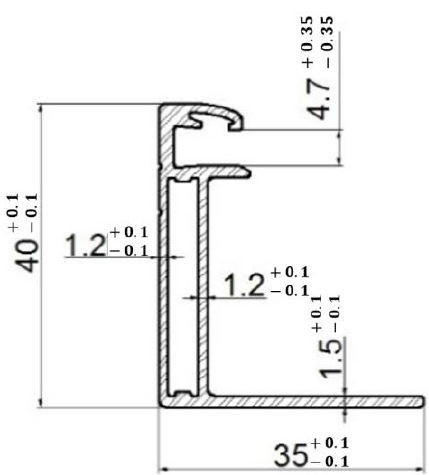
Figure 17. Optimized layer support section.